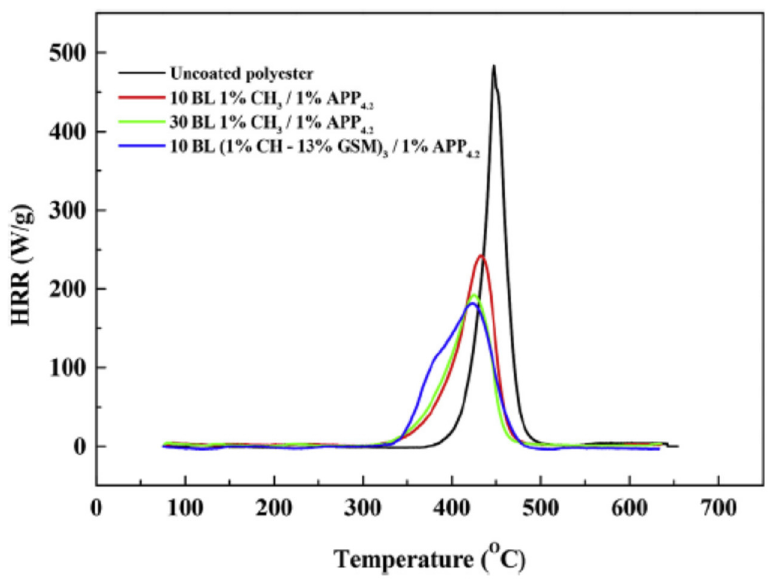
Figure 5. MCC curves of heat release rates as a function of temperature for uncoated and coated polyester [126] Reproduced with permission from Jordanov, I.; Magovac, E.; Fahami, A.; Lazar, S.; Kolibaba, T.; Smith, R.J.; Bischof, S.; Grunlan, J.C. Flame, Polym. Degrad. Stab.; published by Elsevier Ltd., 2019.